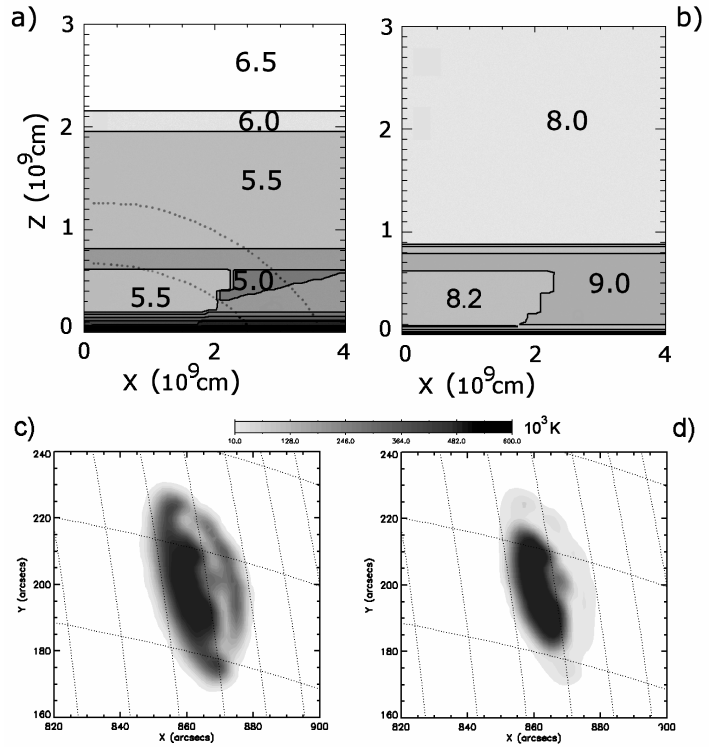
Fig. 4. Vertical section of the axially symmetrical model of the sunspot NOAA 10325 atmosphere. The logarithms of electron temperature [K] (Panel a) and electron density [cm (cid:0) 3] (Panel b) are marked by contours. The dotted lines show gyroresonance levels s = 2 and s = 3 for the 2.52 cm wavelength. The simulation of NOAA 10325 microwave emission for extraordinary (Panel c) and ordinary (Panel d) modes at 2.52 cm under the heliographic longitude 66 ◦